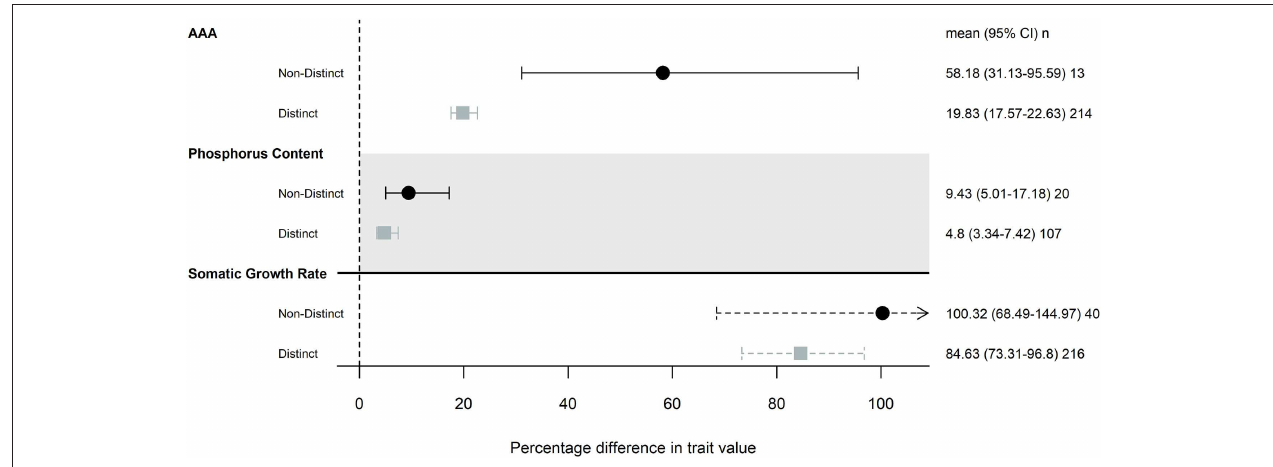
FIGURE 2 | Magnitude of trait differences among pairs of populations that were from environments with distinct levels of P availability (gray) or not (black), that were grown in the same common garden. Only traits that had 10 pairwise comparisons were included in this analysis: somatic growth rate, acquisition, assimilation, and allocation (AAA) and phosphorus content. Points, error bars and line types as in Figure 1